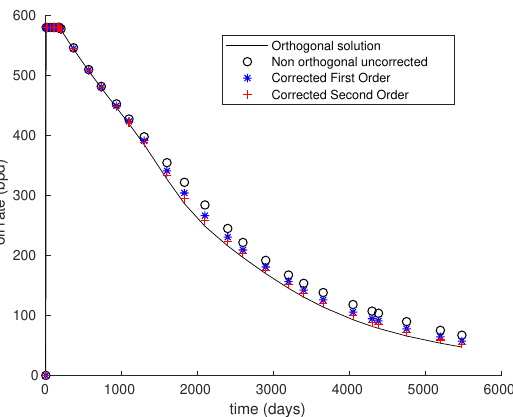
Figure 8. Oil rate at surface computed in orthogonal and non-orthogonal geometries.